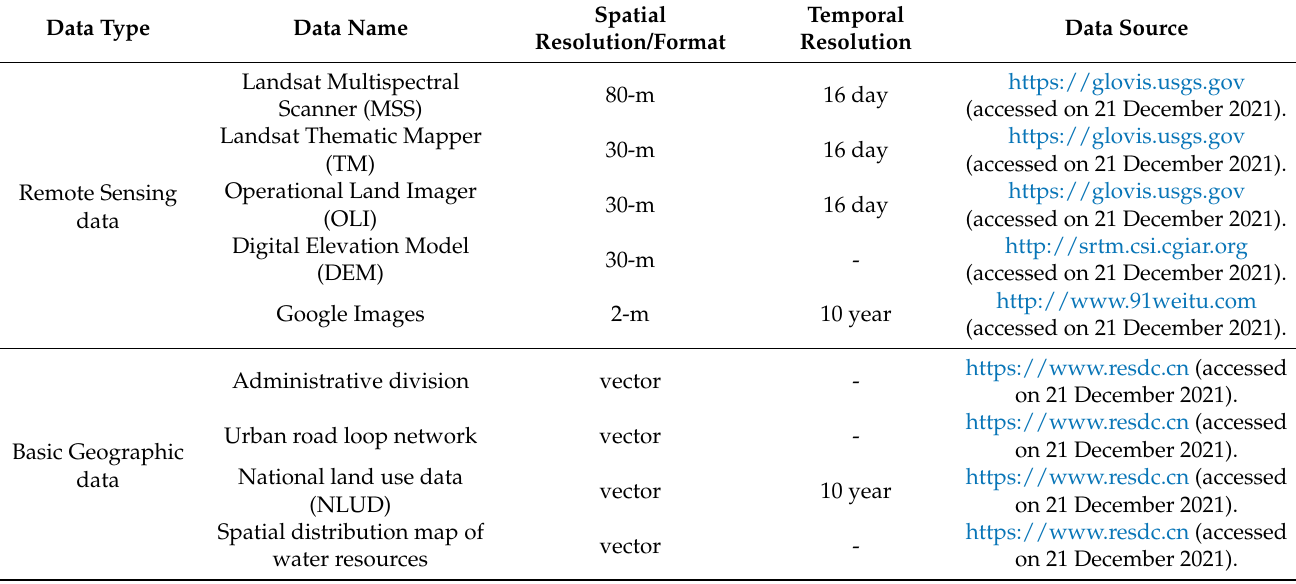
Table 1. The description of the main data that used in this